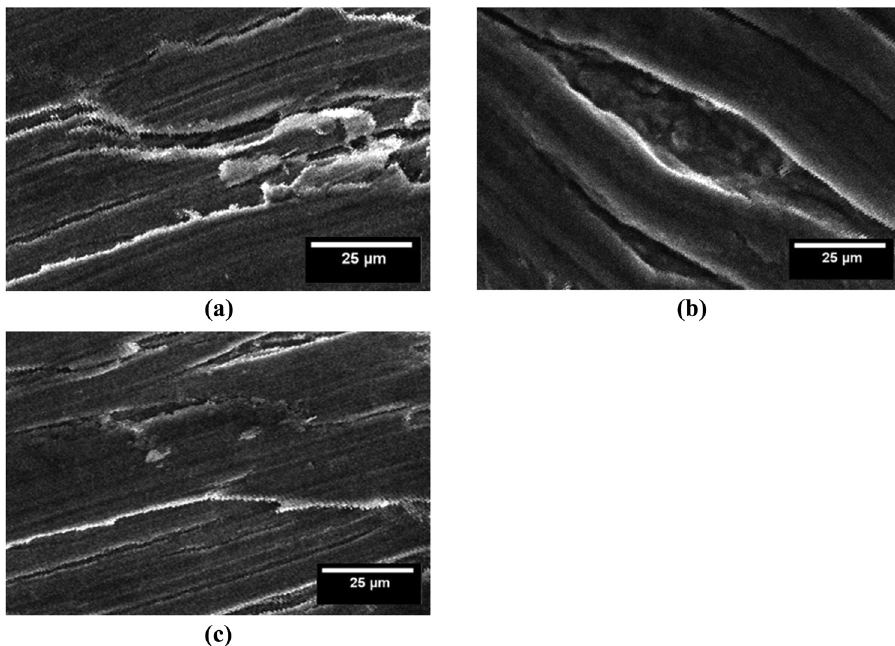
Figure 14: SEM images of wear - tested specimens of ( a ) SEM image of wear - tested W - A, ( b ) SEM image of wear - tested W - 3C, and ( c ) SEM image of wear - tested W -